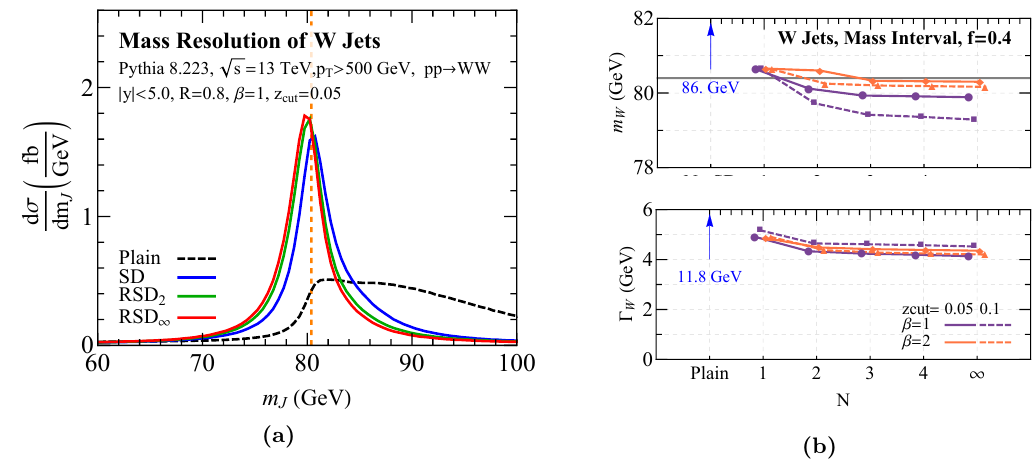
Figure 6. (a) Mass distributions for the W jet sample using di(cid:11)erent levels of RSD and the benchmark values of (cid:12) = 1 and z cut = 0 : 05. (b) Central mass values and widths as a function of N , testing four di(cid:11)erent (cid:12) and z cut combinations, using a mass interval containing a fraction f = 0 : 4 of the